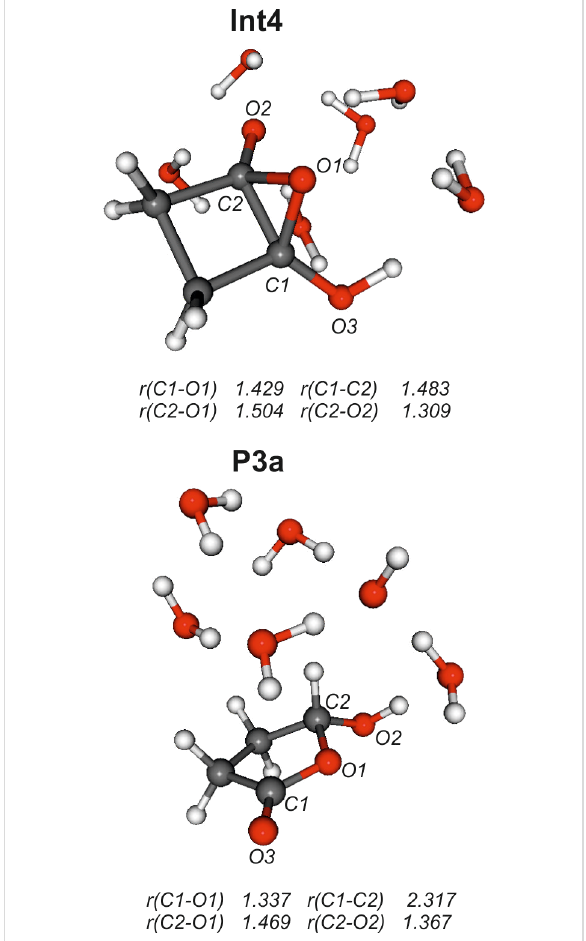
Figure 4: Calculated structures of pertinent stationary points along path C. Distances are given in angstroms (Å).